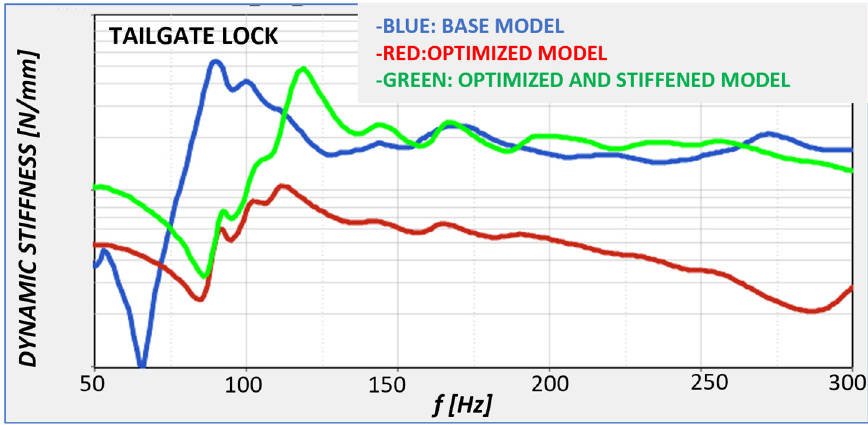
Figure 28. Dynamic stiffness vs. frequency for the tailgate lock.